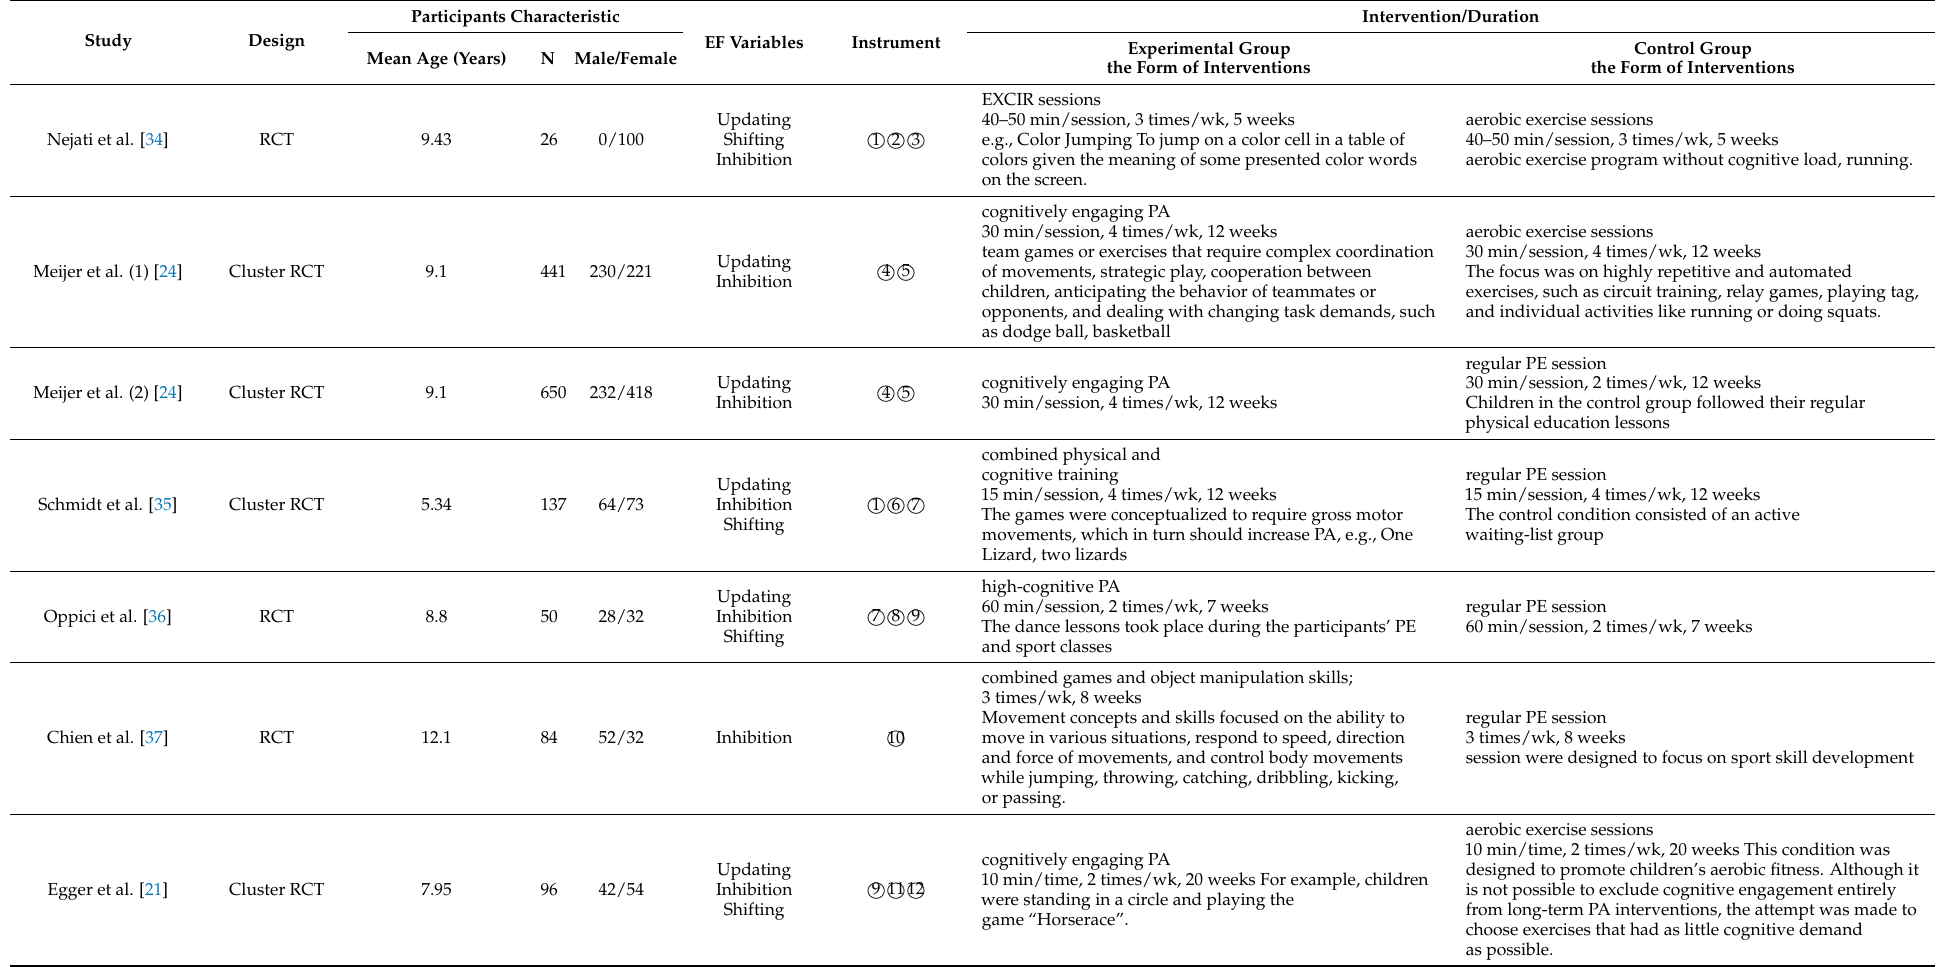
Table 1. Characteristics of studies included in the